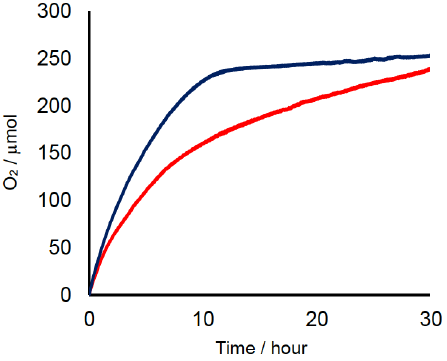
Figure 2. Oxygen evolved from water at pH 1.0 (adjusted by HNO 3 ) catalyzed by the Ruthenium complexes (1.00 µmol, [ 2 ](BF 4 ) 3 , red line; [ 3 ](BF 4 ) 3 , black line) with (NH 4 ) 2 [Ce(NO 3 ) 6 ] (1.00 mmol).